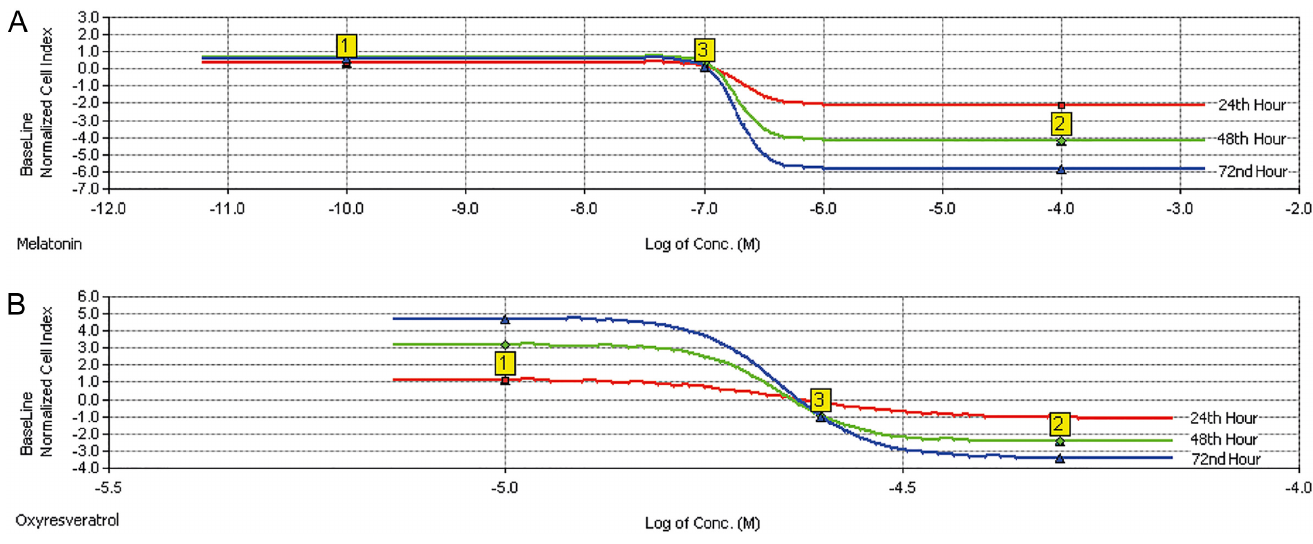
Figure 3. A, B. Dose–response curves of A) melatonin and (B) oxyresveratrol at the 24th, 48th, and 72nd